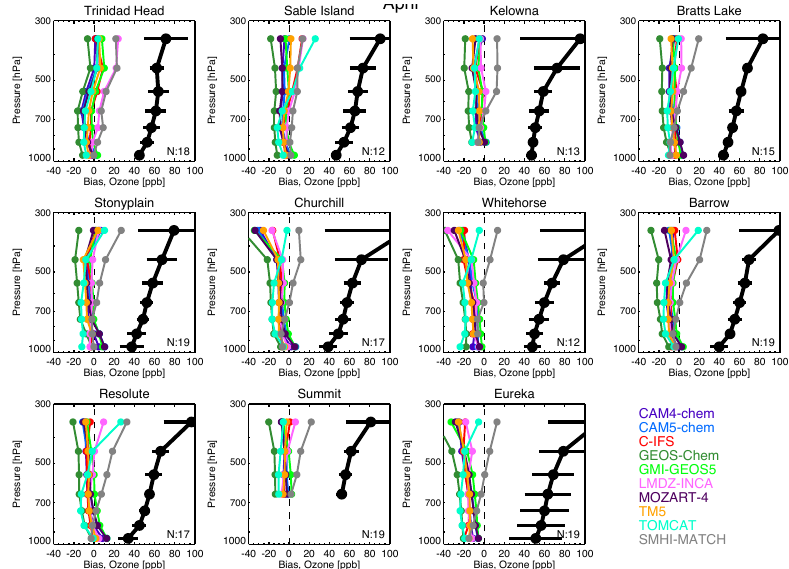
Figure 9. Comparison of models to ozonesondes for April, showing mean and standard deviation of the observations (black line) and the mean bias (colored lines) for each model at each site (Tarasick et al., 2010; Thompson et al., 2011). Results shown for only surface to 300hPa for clarity. The number of sondes for each site is indicated in the lower right corner of each panel.